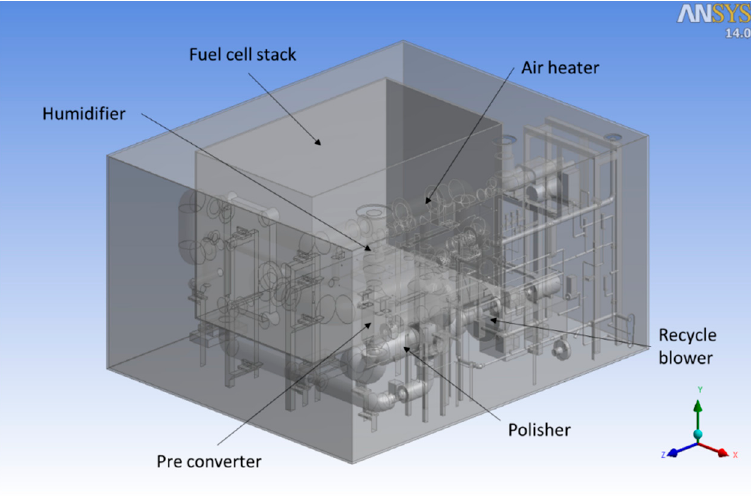
Figure 2. Component locations in a molten carbonate fuel cell (MCFC) stack package.